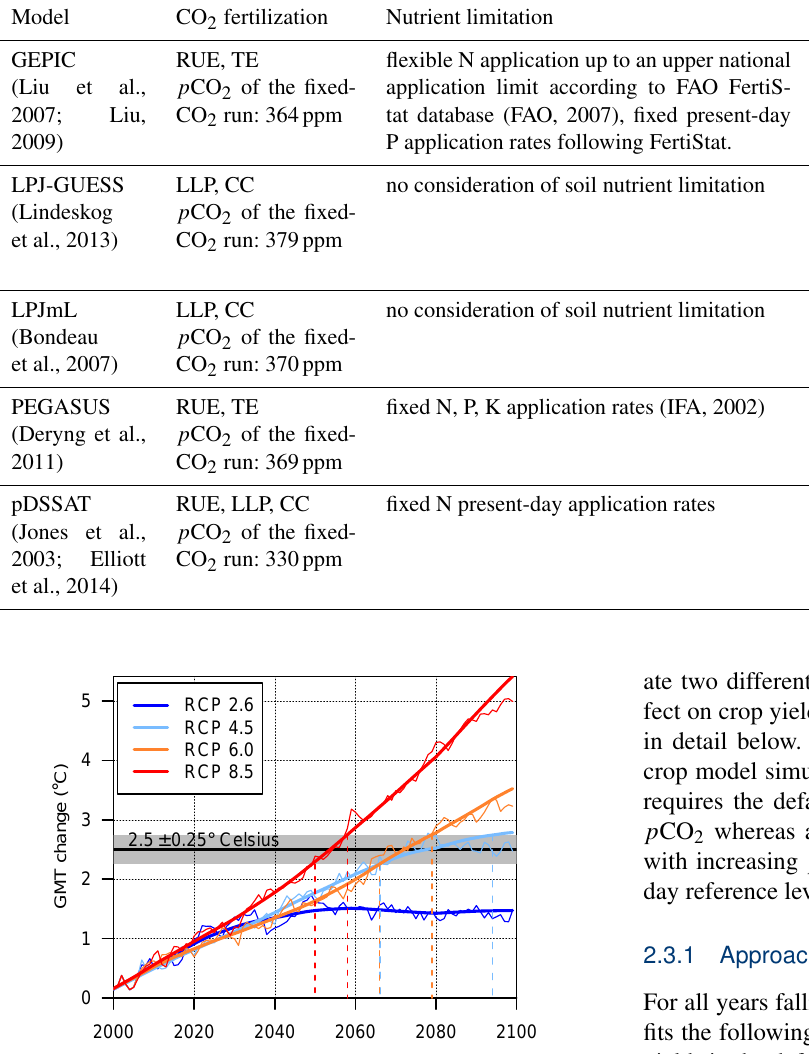
Figure 1. GMT projections from HadGEM2-ES for the four RCPs. The horizontal line and shading indicate the 2.5 ◦ C bin. The orig- inal annual GMT values (thin lines) are smoothed (thick lines) in order to obtain a contiguous time interval for each (cid:49) GMT bin. The smoothing is based on a singular spectrum analysis with a time window of 20 years (R Package Rssa; Korobeynikov, 2010; Golyandina and Korobeynikov, 2014; Golyandina et al., 2015). Years where the thick line falls within the shaded area are asso- ciated with (cid:49) GMT = 2.5 ◦ C, and the corresponding time interval is delineated by the dashed vertical